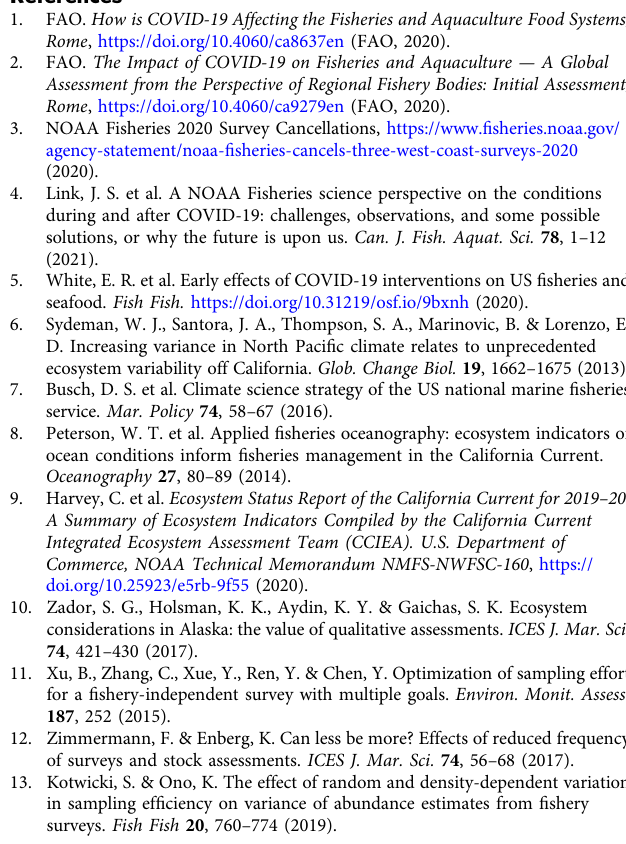
tabledap/FED_Rock fi sh_Catch.html. Paci fi c Fisheries Management Council (PFMC) https://www.pcouncil.org/stock-assessments-star-reports-stat-reports-rebuilding- analyses-terms-of-reference/. Supplementary Software: Computer code, including model fi tting, effort reduction simulation, and application of krill species distribution model, are provided within the Supplementary Software fi le. Source data are provided with this